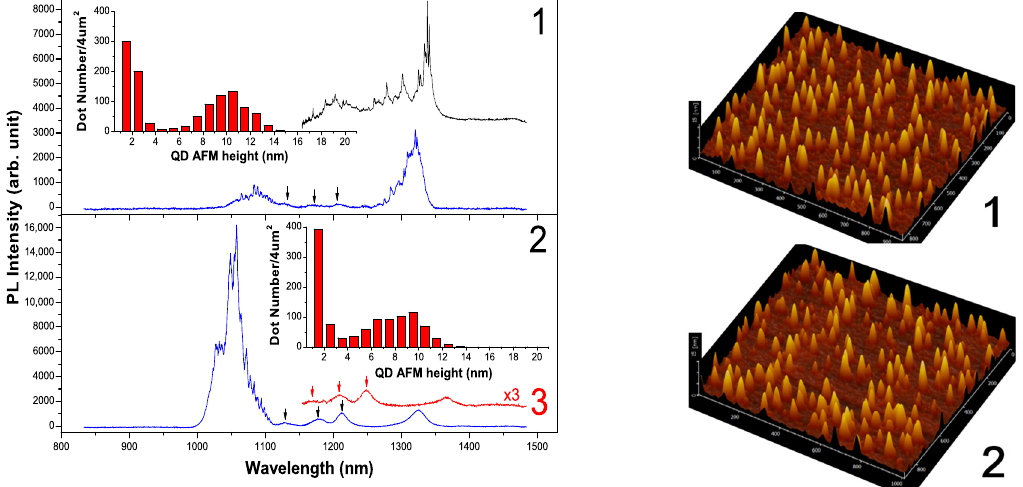
Figure 1. ( left ): µ PL spectra of bilayer QDs: region 1 shows individual QDs at λ ~1.32 µ m with exciton lines, two points, in blue and black curves; region 2 shows individual QDs at λ ~1.32 µ m in lower aspect ratio and smooth spectral profile, a strong profile at λ ~1.05 µ m from small QDs; region 3 shows extended λ ; ( right ): AFM images; ( inset ): statistics on QD AFM height.